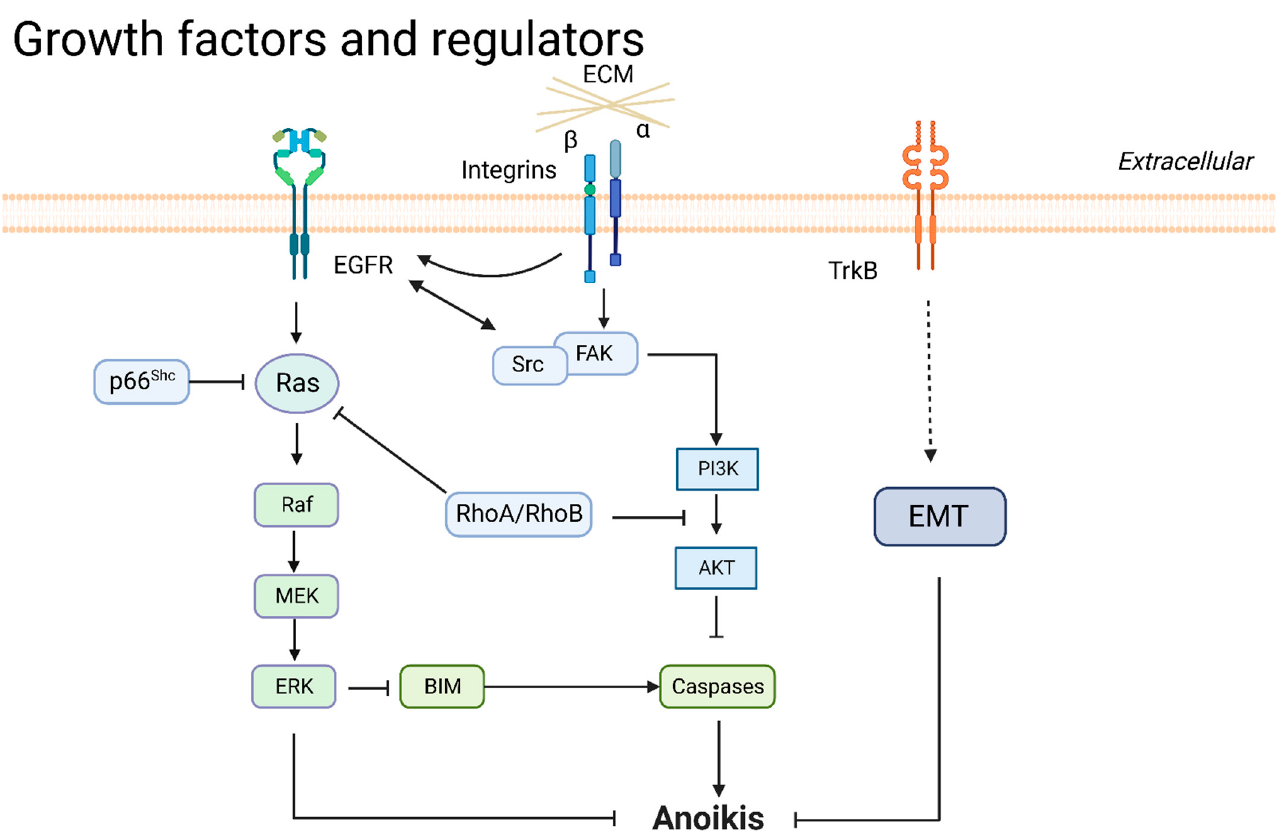
Figure 3. Growth factors and regulators in anoikis.